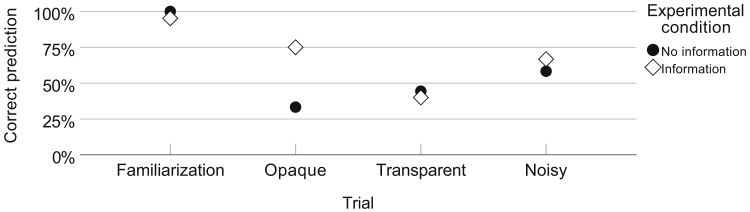
Exogenous Facilitation ExperimentThe proportion of correct predictions across opaque, transparent, and noisy test trials in the no-information and information conditions.